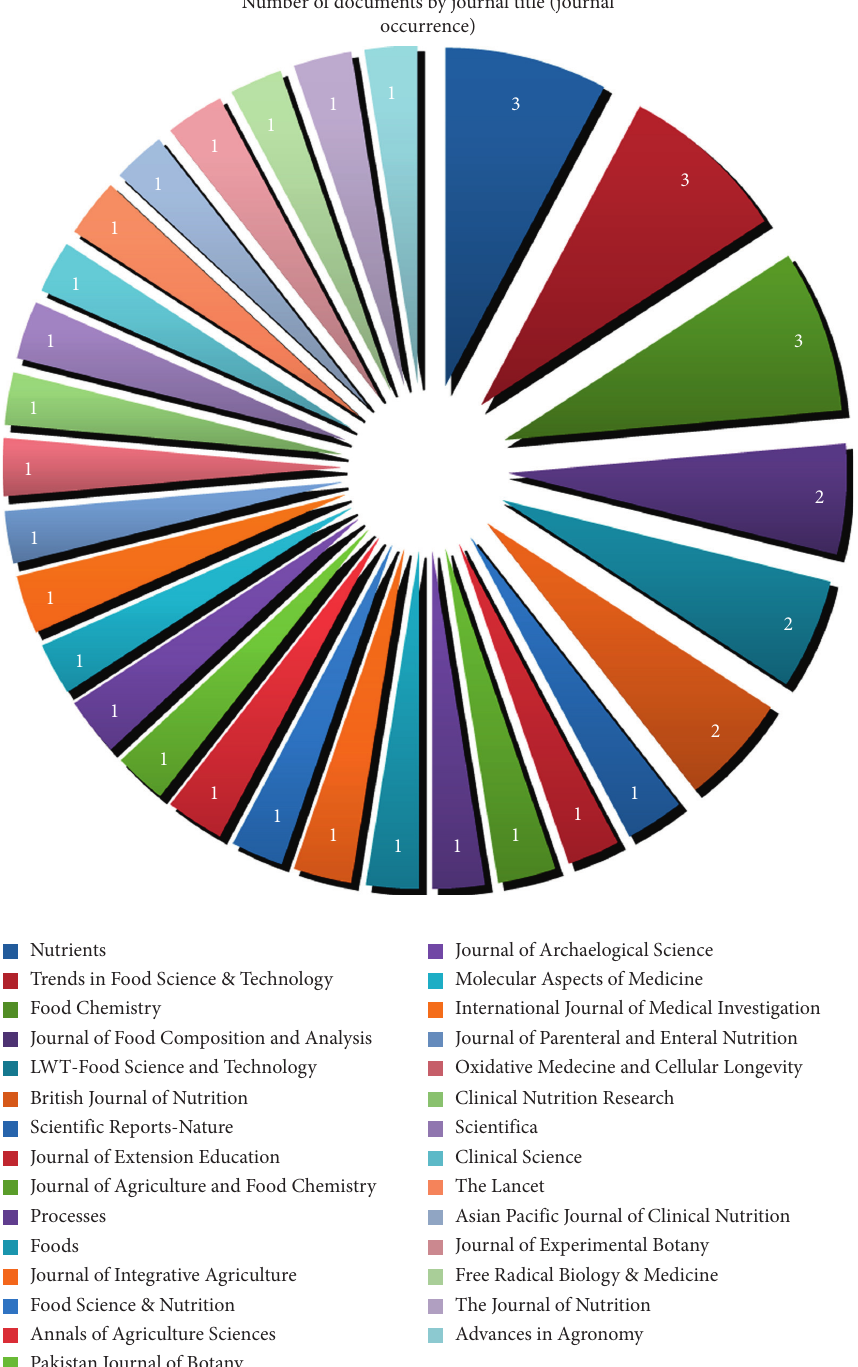
Figure 1: Number of documents by journal’s